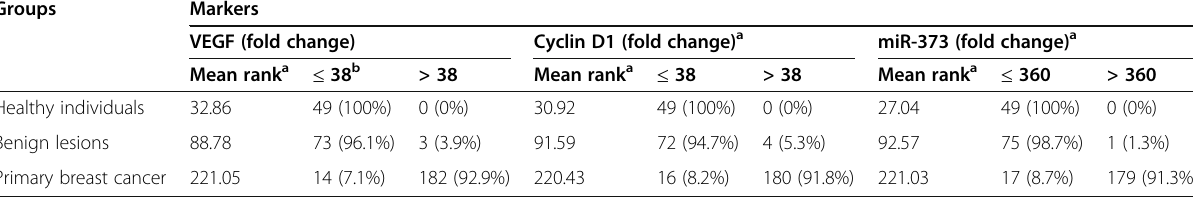
Table 2 Frequency distributions of investigated markers among different studied groups